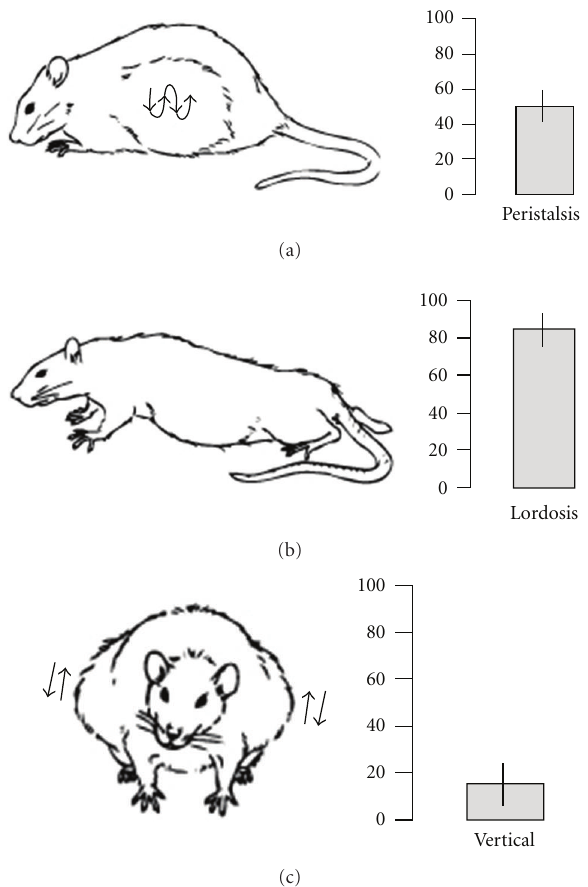
Figure 1: Frequency of three types of labor contractions observed in Norway rats. Histograms show mean frequency of peristalsis, lordosis and vertical contractions counted from videorecordings of labor in the six hours prior to delivery of the first pup ( n = 8 dams). Based on data from